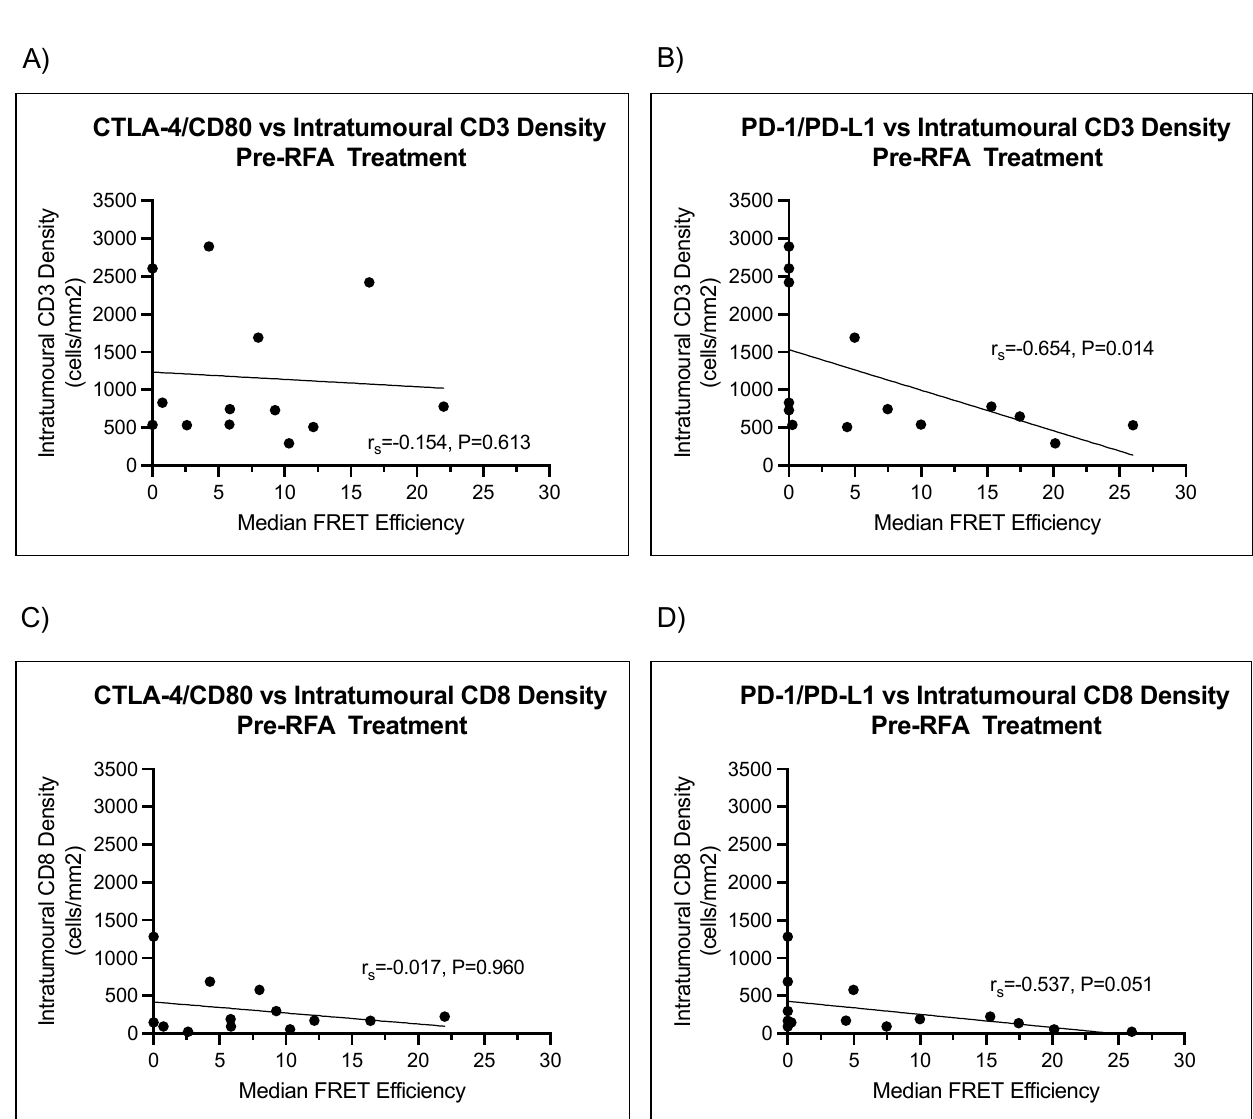
Figure 6. PD-1/PD-L1 interaction state negatively correlates with intratumoral CD3 and CD8 density in lung 1. (A) Scatter plots demonstrate a lack of correlation between intratumoral CD3 density (cells/mm 2 ) and median CTLA-4/CD80 interaction (r s = − 0.154, p = 0.613) in metastases analyzed from lung one (pre-RFA). ( B ) A moderate negative correlation exists between intratumoral CD3 density and median PD-1/PD-L1 interaction state (r= − 0.654, p = 0.014). This indicates, with signifi- cance, that higher median PD-1/PD-L1 interaction states are detected in areas with lower intra- tumoral CD3 density. ( C ) Scatter plots demonstrate a lack of correlation between intratumoral CD8 density (cells/mm 2 ) and median CTLA-4/CD80 interaction (r s = − 0.017, p = 0.960) in metastases ana- lyzed from lung one (pre-RFA). ( D ) A moderate negative correlation exists between intratumoral CD8 density and median PD-1/PD-L1 interaction state (r s = − 0–537, p = 0.051). Whilst not statistically significant, this is a moderate trend that may achieve significance with higher sample numbers.